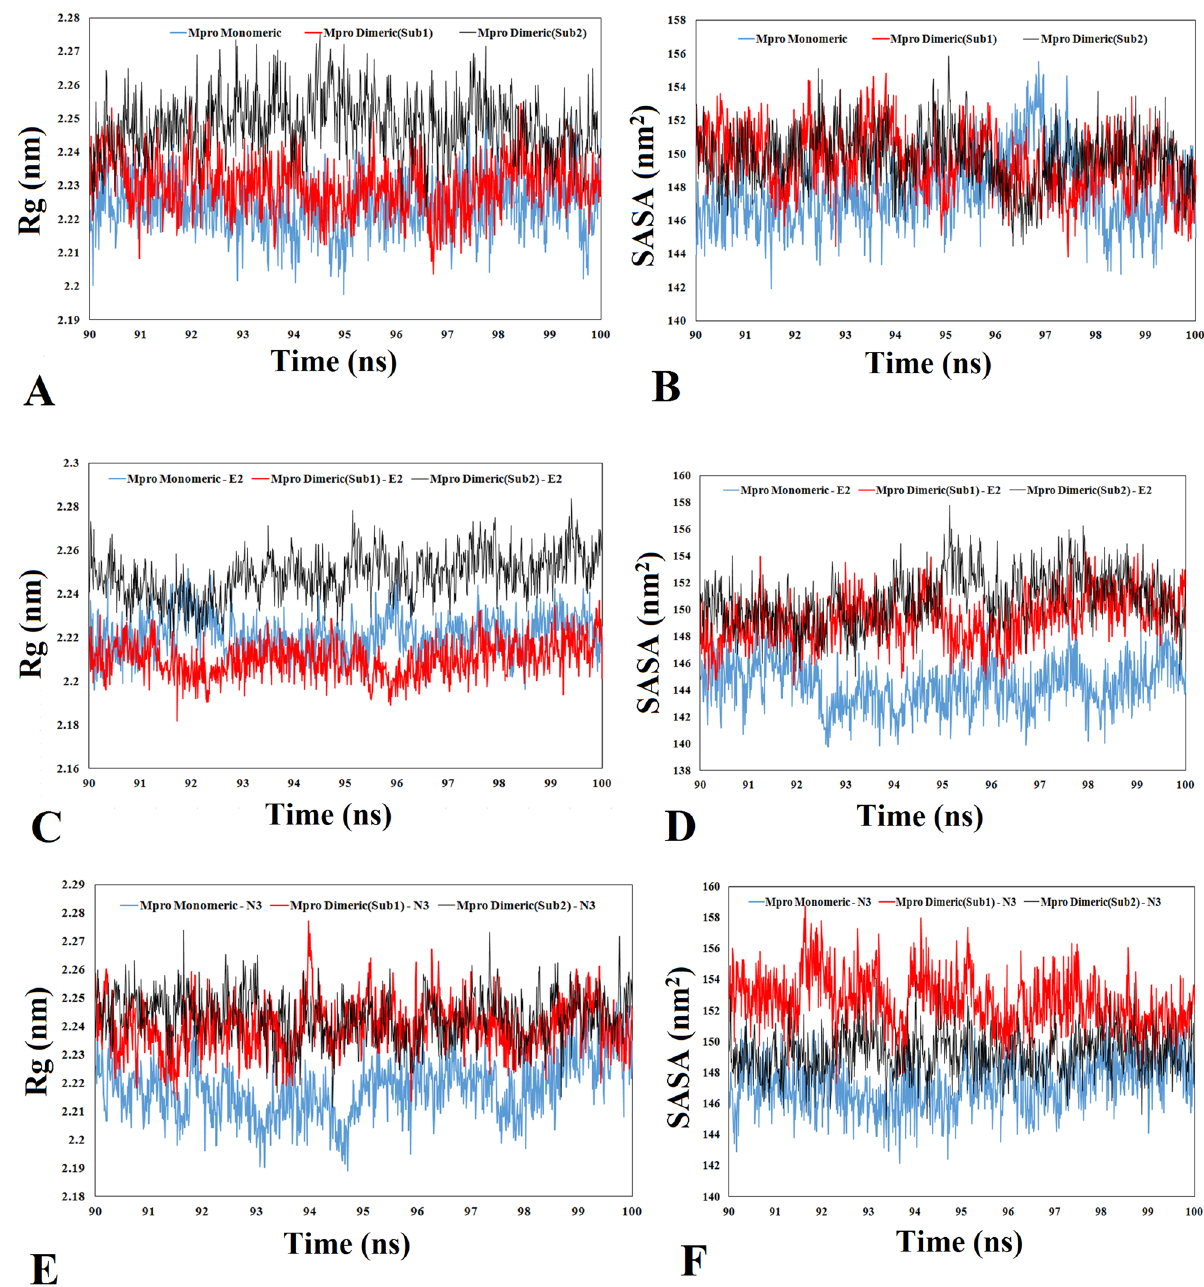
Figure 4. Conformational changes of protease in monomeric and dimeric states. Radius of gyration (RG) and solvent accessibility surface area (SASA) of two forms of protease ( A , B ) in absence, and ( C , D , E , F ) presence of E2 and N3